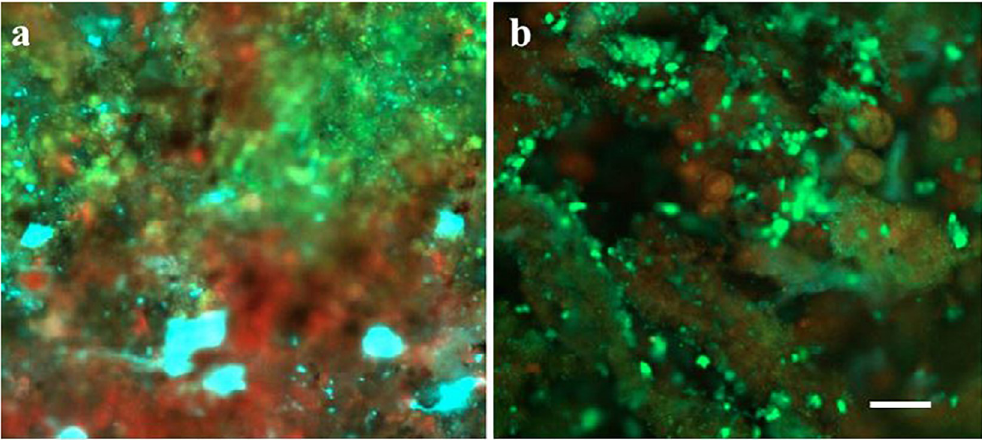
Fig 4. Distribution of protein (green), alpha polysaccharides (red), and polymers with β structures (cyan) in FS IFAS biofilms, (a) intact, and (b) sloughed biofilm. Scale = 200 μ